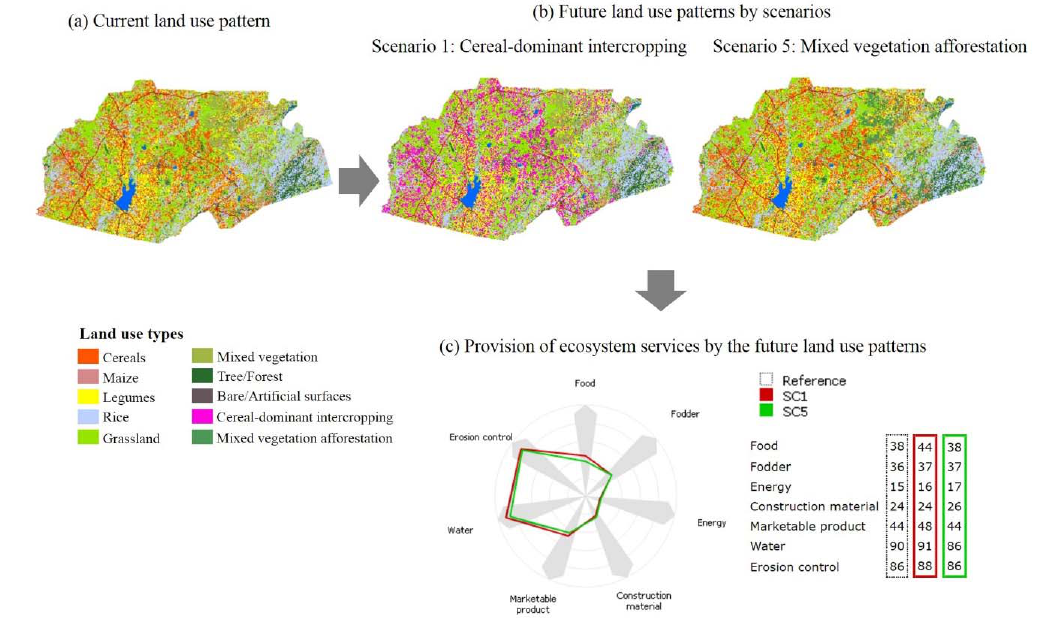
Figure 5. Future land use patterns of selected land use scenarios and spider charts for the values of ecosystem services supplied by the model output for Bongo. The example shows the impacts of cereal-dominant intercropping (SC 1) and mixed vegetation afforestation (SC 5) on the current land use patterns ( b ), and resulting changes in ecosystem services provision ( c ).